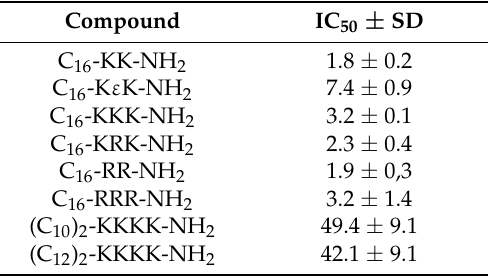
Table 2. Values of IC 50 (mg/L) and their standard deviations obtained for the tested compounds on HaCaT keratinocytes exposed to their action for 24 h.